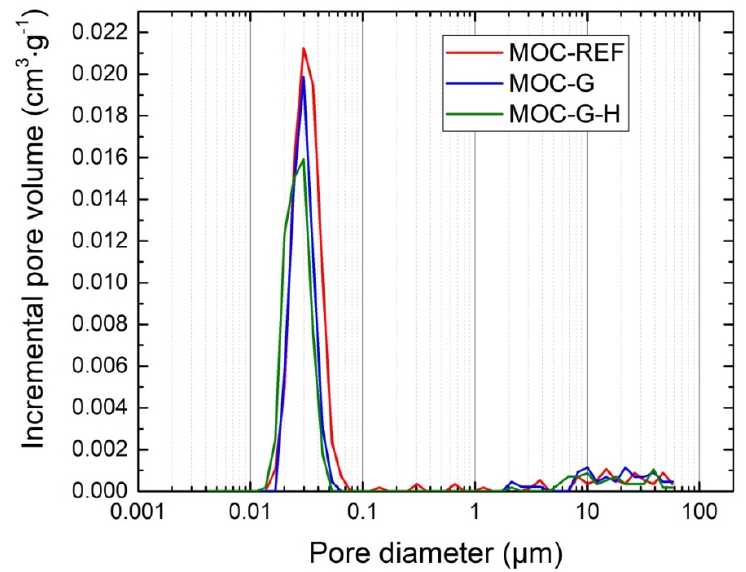
Figure 9. Incremental pore volume distribution for 14-day composites.